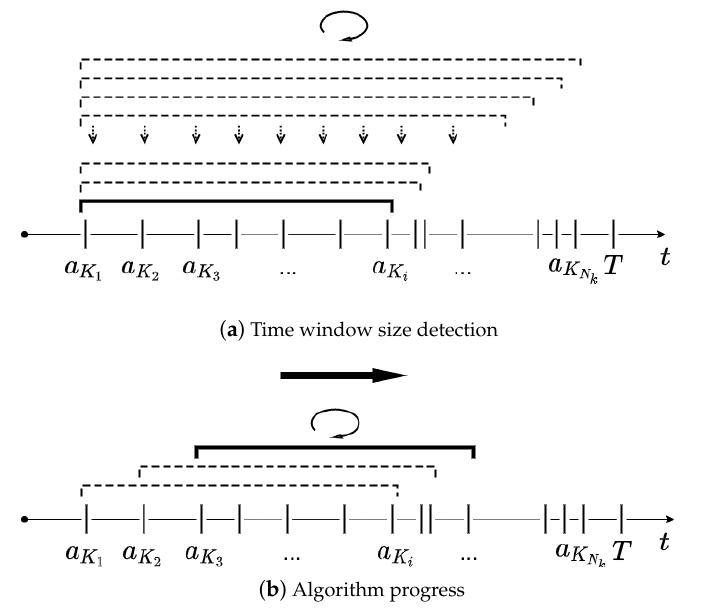
Figure 3. Q-OPT algorithm-time window size detection on each step.